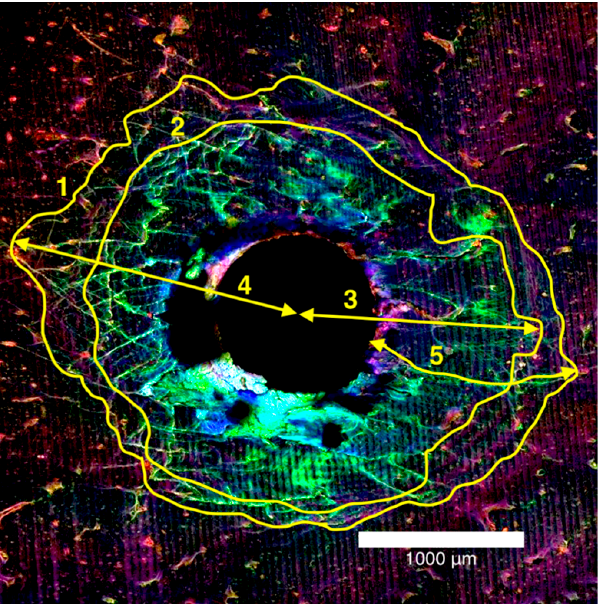
Figure 3. Laser confocal microscope composite image of the entry surface of a 2.0 mm thick bone block specimen (1) total damage area, (2) diffuse damage area, and mm for (3) maximum damage radius, (4) maximum diffuse damage radius, (5) maximum crack length.